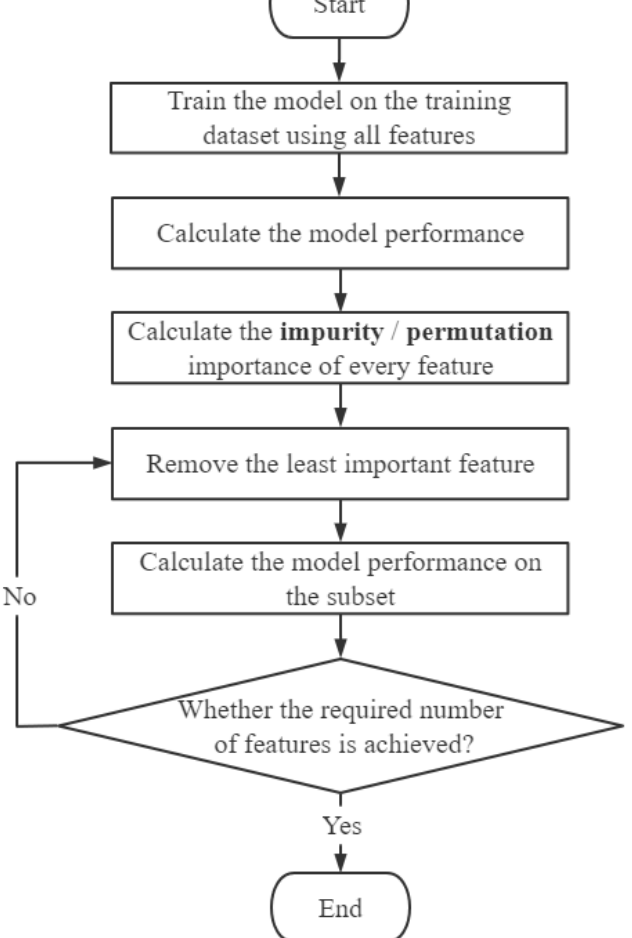
Figure 3. The procedure of the RFE